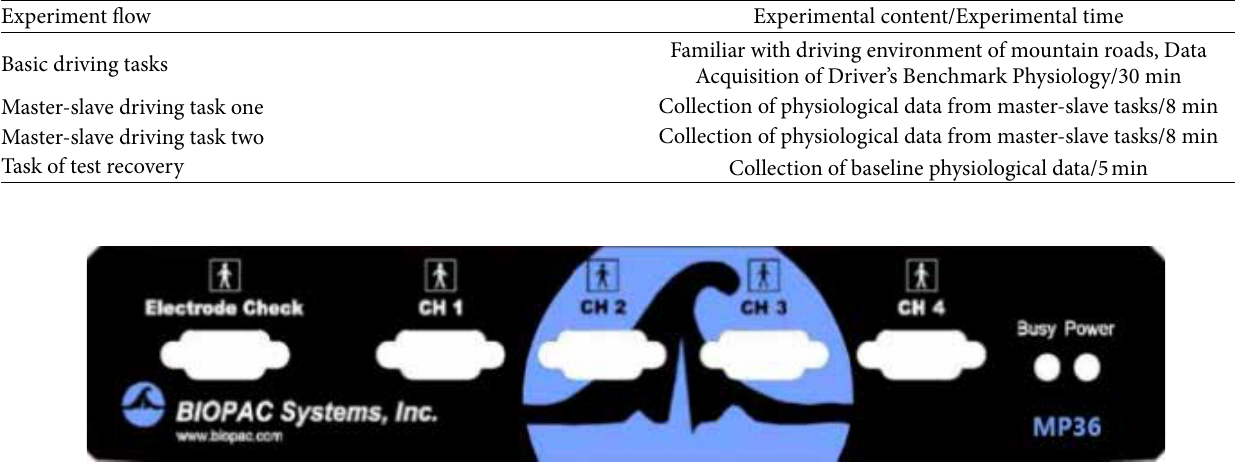
Figure 4: BIOPAC physiological instrument